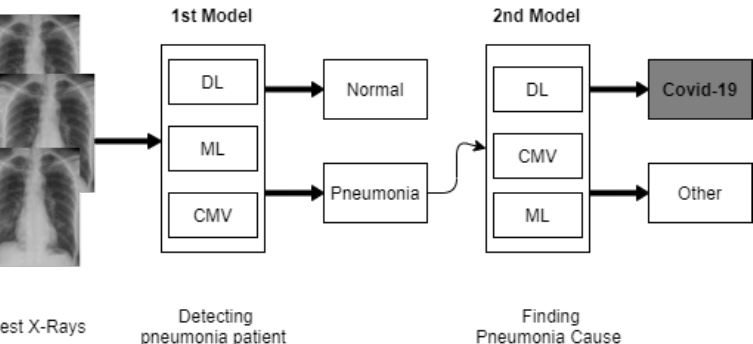
Figure 3. Our representation of the proposed computation intelligent models used at Cranfield University